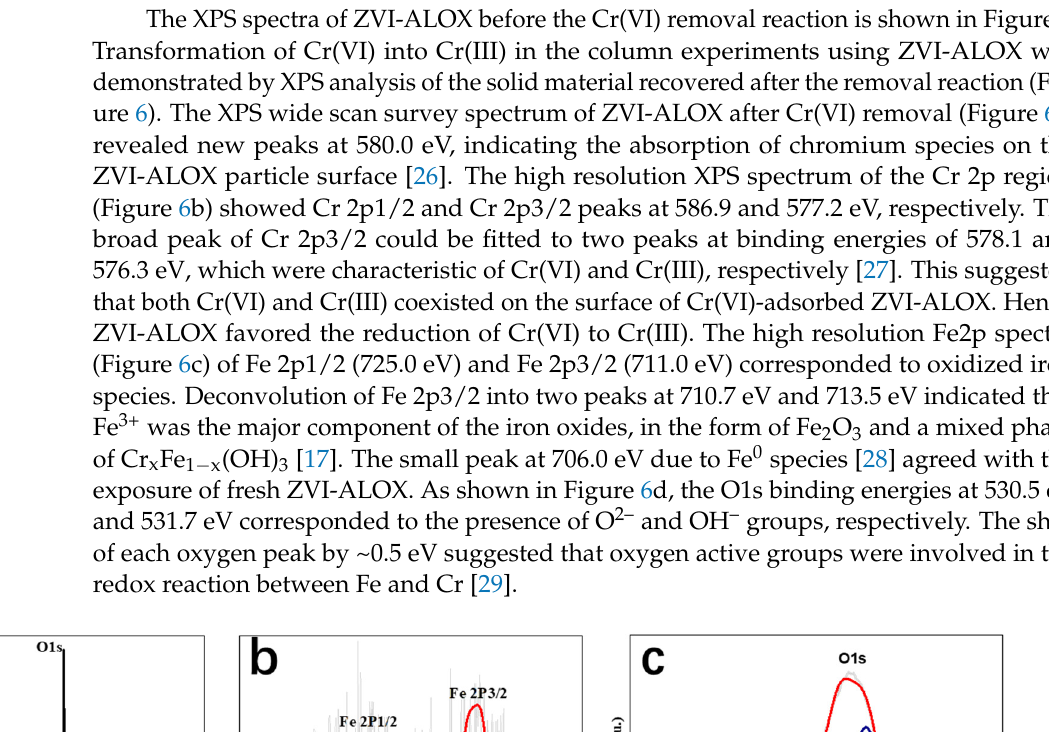
Figure 6. XPS spectra of ZVI-ALOX after the Cr(VI) removal reaction: ( a ) wide scan survey spec- trum; ( b – d ), high resolution spectra of Cr 2p, Fe 2p and O1s. 3.5. EE Measurements EE is a quantitative measure of electron utilization during the ZVI target reduction process, which provides a basis to improve economic efficiency. The physical structures of ZVI, initial concentration of the target solution, mode of reaction and the substrate sys- tem all affected EE values (Figure 7). Figure 7a shows that the EE of ZVI-ALOX and ZVI both increased with increasing initial Cr(VI) concentration. Compared with ZVI, the val- ues of EE obtained with ZVI-ALOX were higher at all concentrations, especially at 5 mg/L Cr(VI). This suggested that the interface between Al 2 O 3 and ZVI in the microspheres played an important role in the utilization of ZVI. Both ZVI-ALOX and ZVI gave higher EE values in the column removal mode. Obviously, compared with the batch removal of Cr (VI), the EE values of isolated ZVI were significantly higher (39.1% vs 5.12%) (Figure 7b).